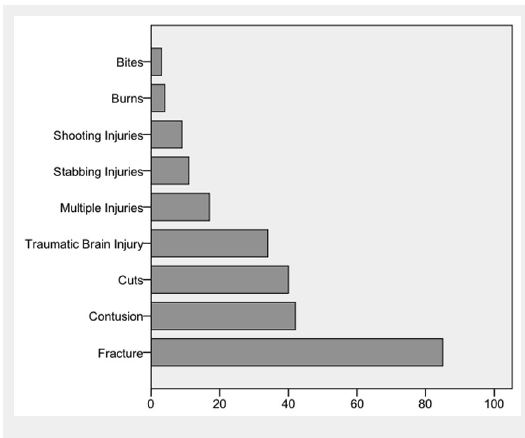
Summary of admissions related to trauma (number of patients per